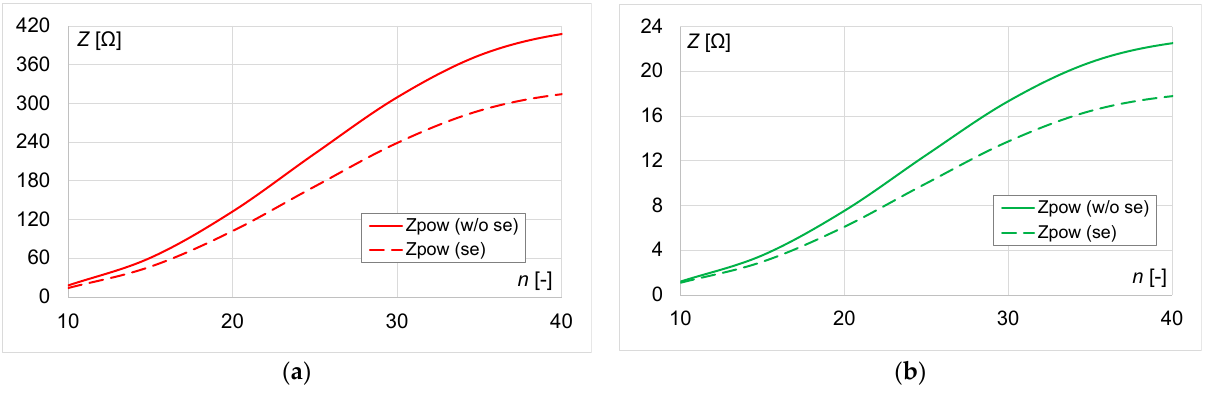
Figure 15. Load impedance for the cases with and without skin effect at 1 MHz for the small coil at